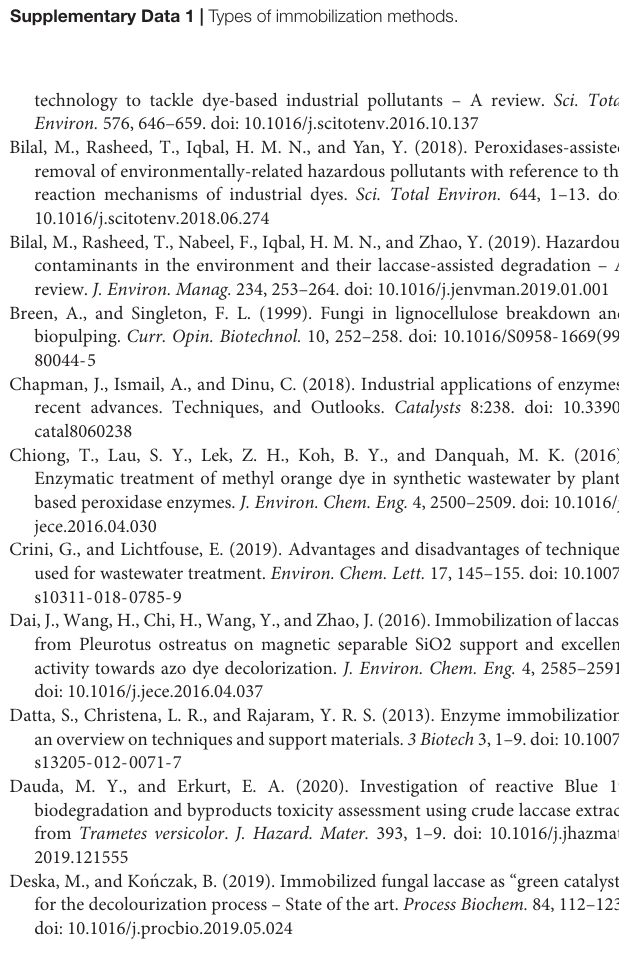
Supplementary Figure 1 | Basic methods of enzyme immobilization. Supplementary Table 1 | Classification of dyes according to industrial application, particle charge after dissolution and chromophore structure. Supplementary Data 1 | Types of immobilization